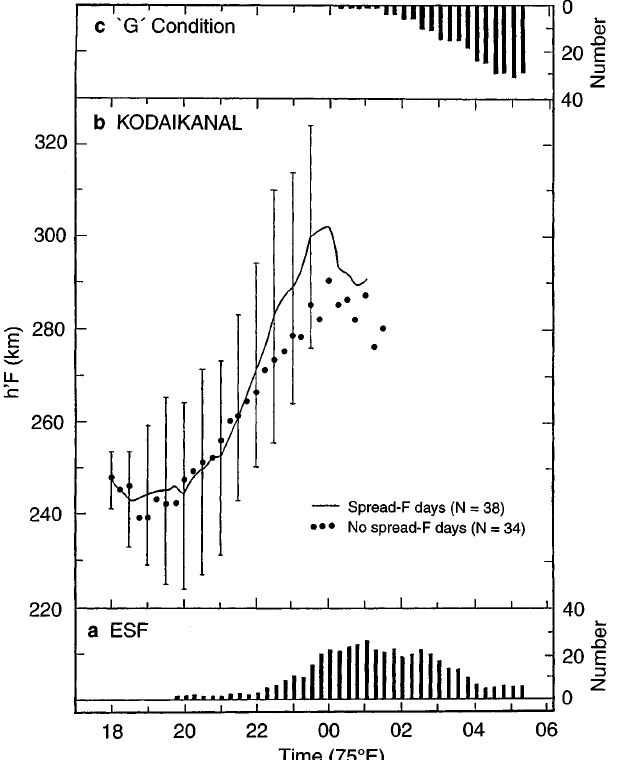
Fig. 2. Local time variation of average h 0 F on nights with and without spread-F in post-midnight hours. The vertical bars represent standard deviations of the average values for spread-F nights. Also shown are the local time variation of spread-F occurrence and G (no echo) condition for the set of spread-F nights